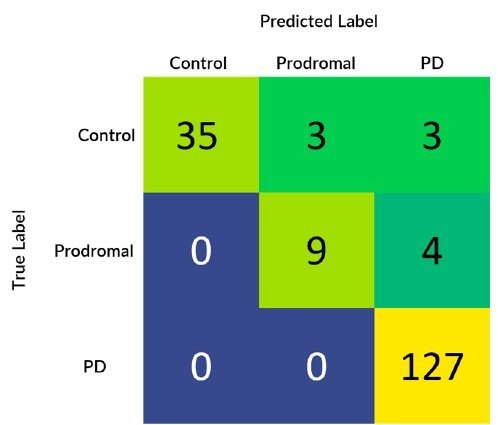
Figure 7. Confusion matrix of artificial neural network at test split 2.